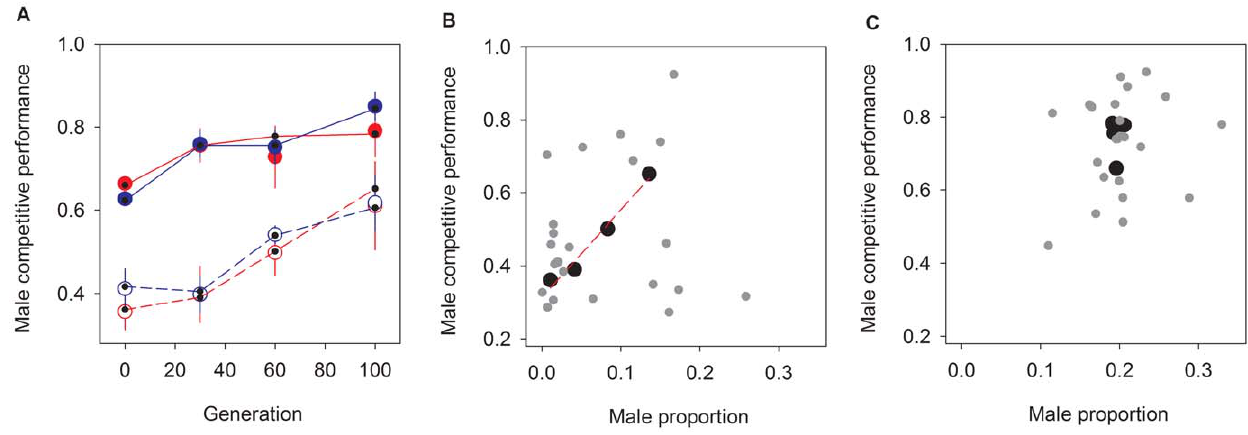
Figure 6. Evolution of male competitive performance. In A , the proportion of wild type progeny originated from the competition of experimental males with tester GFP males for the fertilization of standard females (see Materials and Methods). Dioecious populations are shown in blue, androdioecious populations in red. Empty circles show populations without initial genetic diversity and filled circles populations with initial diversity. Circles and bars represent the average values among replicate populations and associated SEM, respectively. Lines connect the least-square estimates (dots) obtained after ANOVA (see Table 1 for analysis). In B , for the androdioecious populations without standing diversity (empty circles) the least-square estimates of male competitive performance (dots in panel A ) are shown against the least-square estimates of male proportions observed (dots in Figure 4B ). The correlation among both phenotypes in these populations is positive and significant ( r =0.99; t 2 =9.2; p =0.006). In gray the least-square estimates by replicate population at each generation from a fully nested model ( Table S3 ). The correlation among these estimates is not significant. In C , as in B , for androdioecious populations with initial diversity (the correlations among phenotypes are not significant).